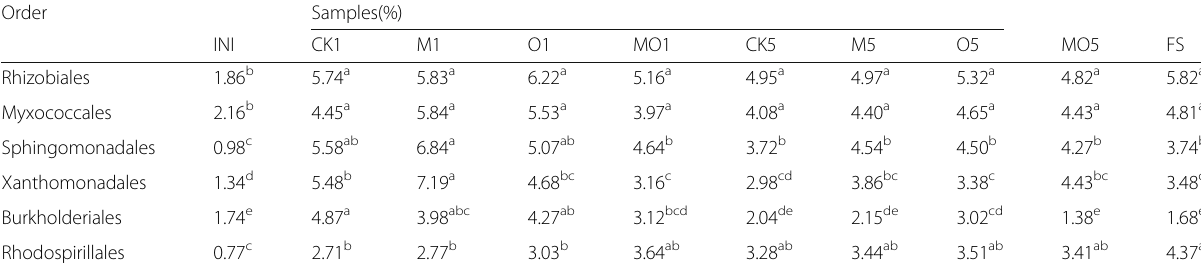
Table 3 Relative abundance of phylogenetic order under the Phylum of Proteobacteria at each experimental site (relative abundance > 1%)